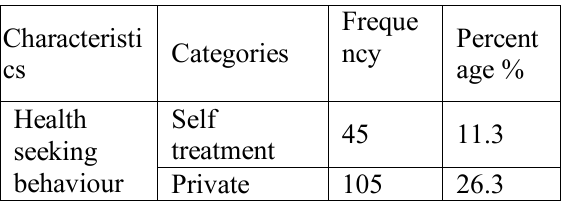
Table no 3: Distribution of health care utilization for reported illness among the senior citizens.